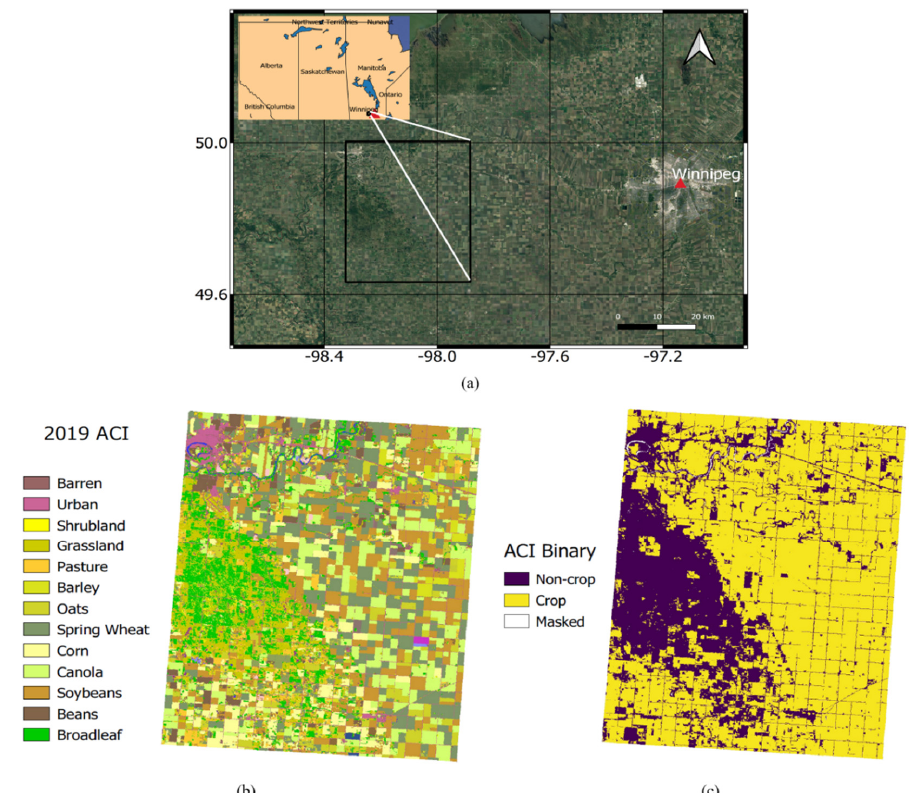
Figure 1. ( a ) The heterogeneous agricultural study area located near Carman, Manitoba, Canada (black box); ( b ) dominant land cover types include annual and perennial crops, with small towns and limited forest and shrub covers; ( c ) binary classification as crop and non-crop according to the Agriculture and Agri-Food Canada (AAFC) Annual Crop